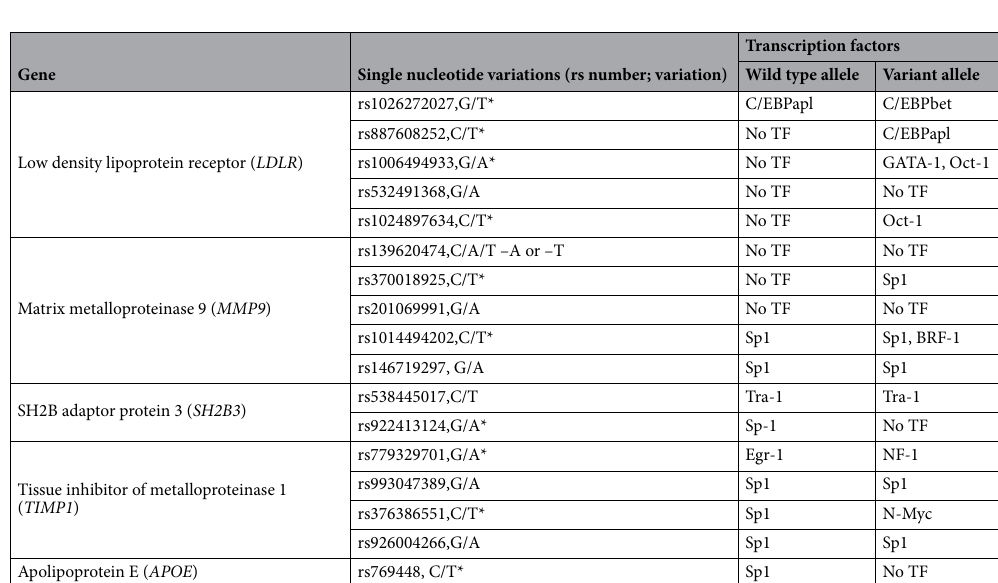
Figure 3. Single nucleotide variations showing influence on CGIs status & size for ACAT1 , APOB , APOE , CYBA , FAS , FLT1 , KSR2 , LDLR , MMP9 , PCSK9 , PHOX2A , REST , SH2B3 , SORT1 and TIMP1 genes.